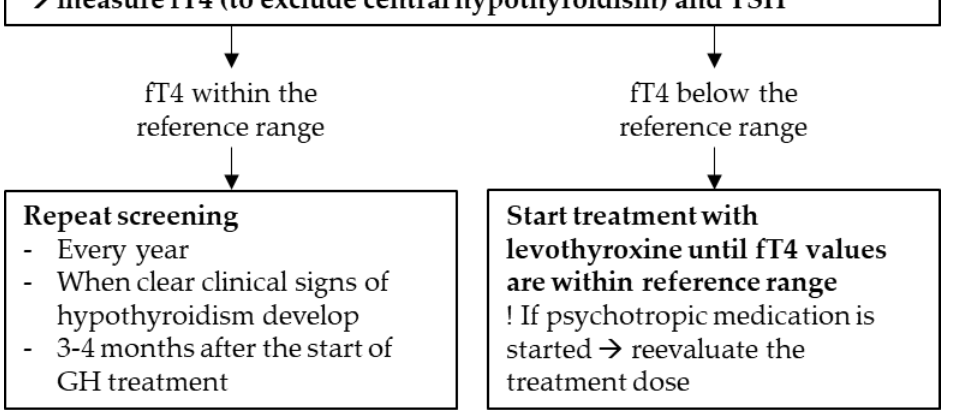
Figure 2. Recommendations for the screening and treatment of hypothyroidism in adults with Prader – Willi